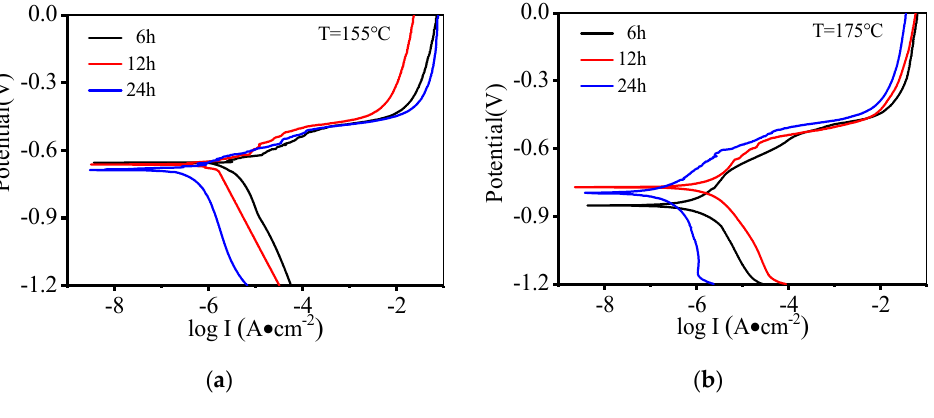
Figure 4. Polarization resistance (R p ) under different aging conditions.